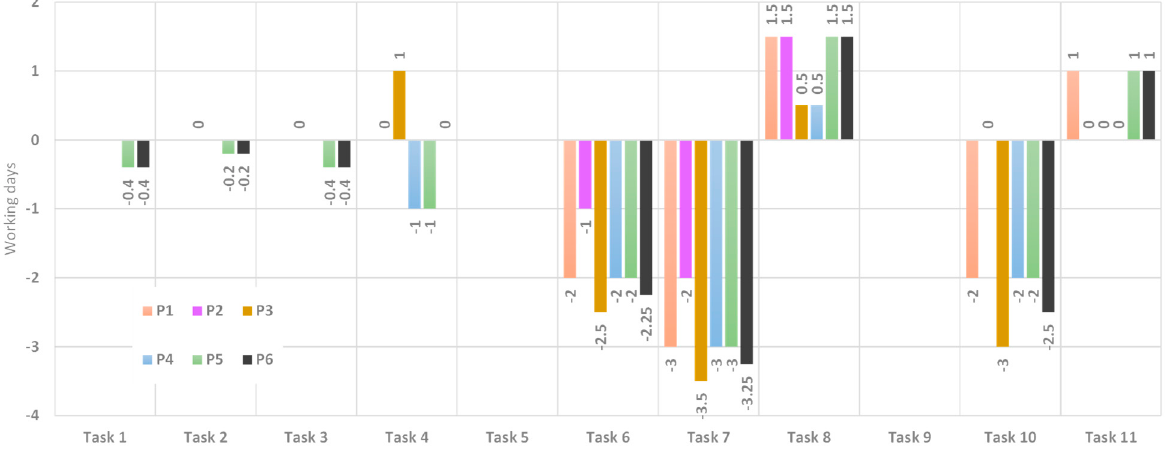
Figure 3. Deviation between the durations proposed by ChatGPT and the baseline for each task from each participant (P).